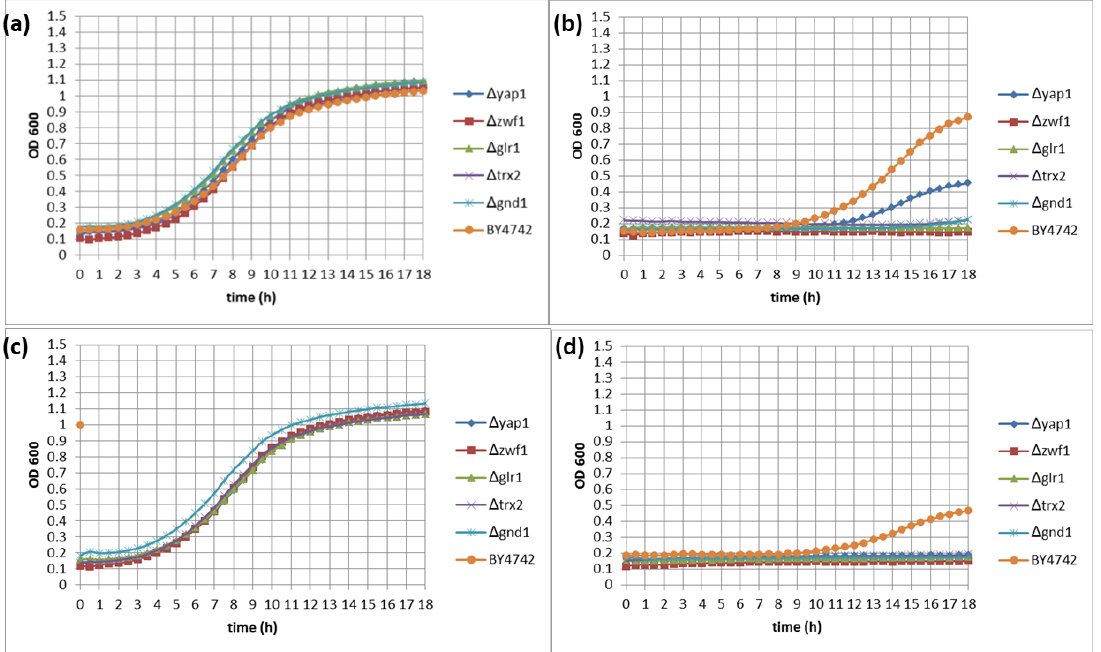
Figure 3. Effects of selenocyanates on the growth in shake culture of wt BY4742 and Δyap1 , Δglr1 , Δzwf1 , Δgnd1 and Δtrx2 mutant yeast cells in complete supplement medium (CSM). ( a , c ) CSM alone (control), ( b ) 15 μM of Compound 1 , and ( d ) 15 μM of Compound 2 . The experiments were repeated twice (growth curves were measured in triplicates) with similar results.